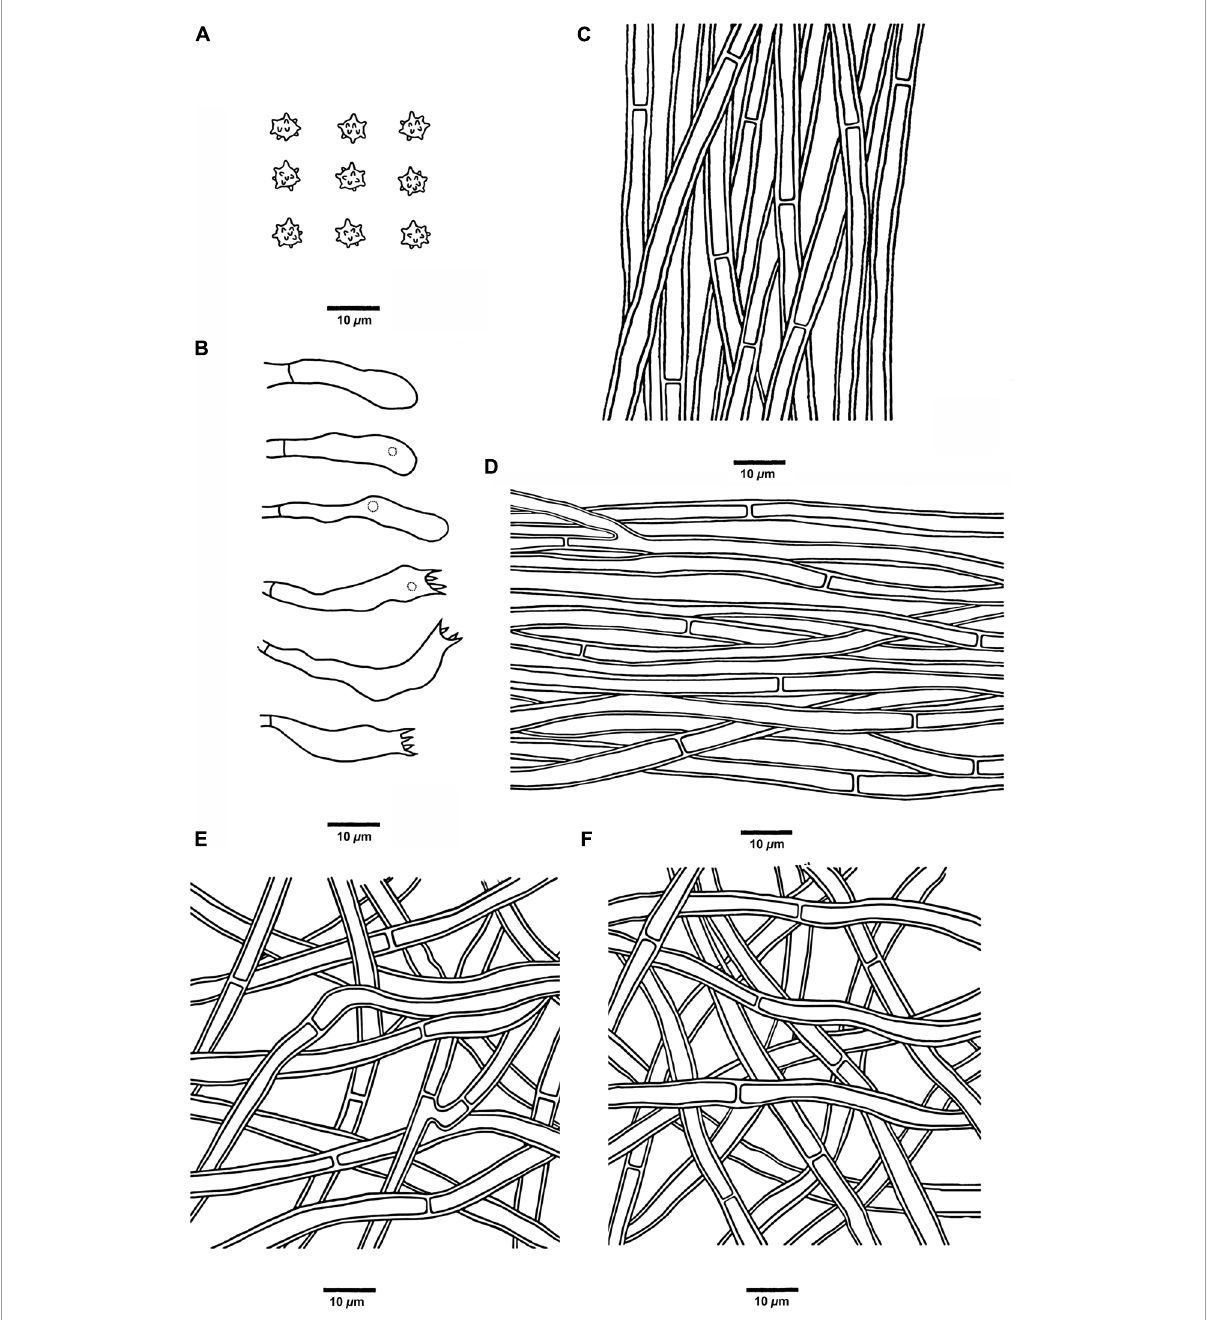
FIGURE9 Microscopic structures of H. radiatum (drawn from Cui 17130). (A) Basidiospores, (B) Basidia and basidioles, (C) Hyphae from context, (D) Hyphae from spines, (E) Hyphae from the inner layer of stipe, and (F) Hyphae from the surface layer of stipe.